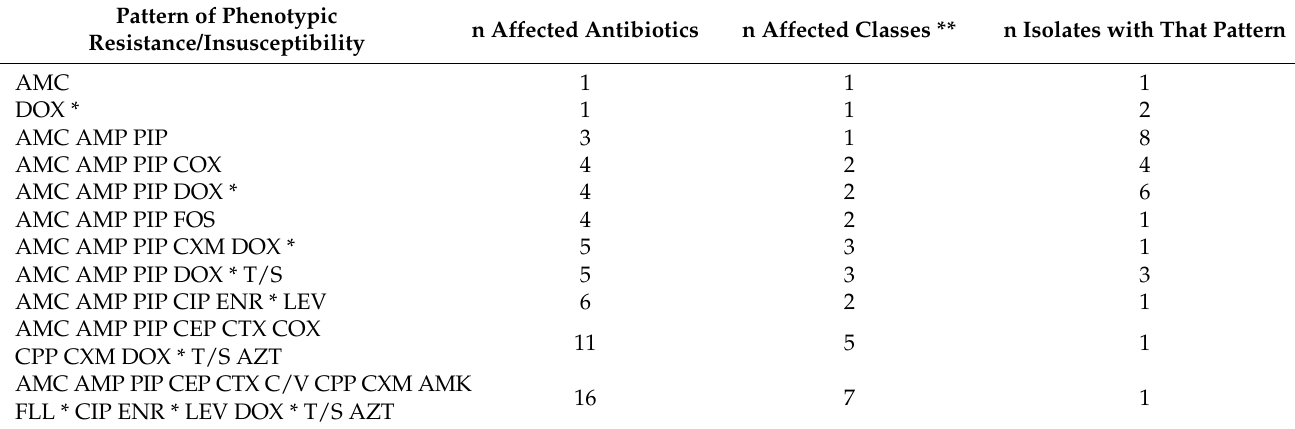
Table 14. Resistance Patterns of all E. coli isolates ( n = 29) from the same piece of belly meat of a pig from farm